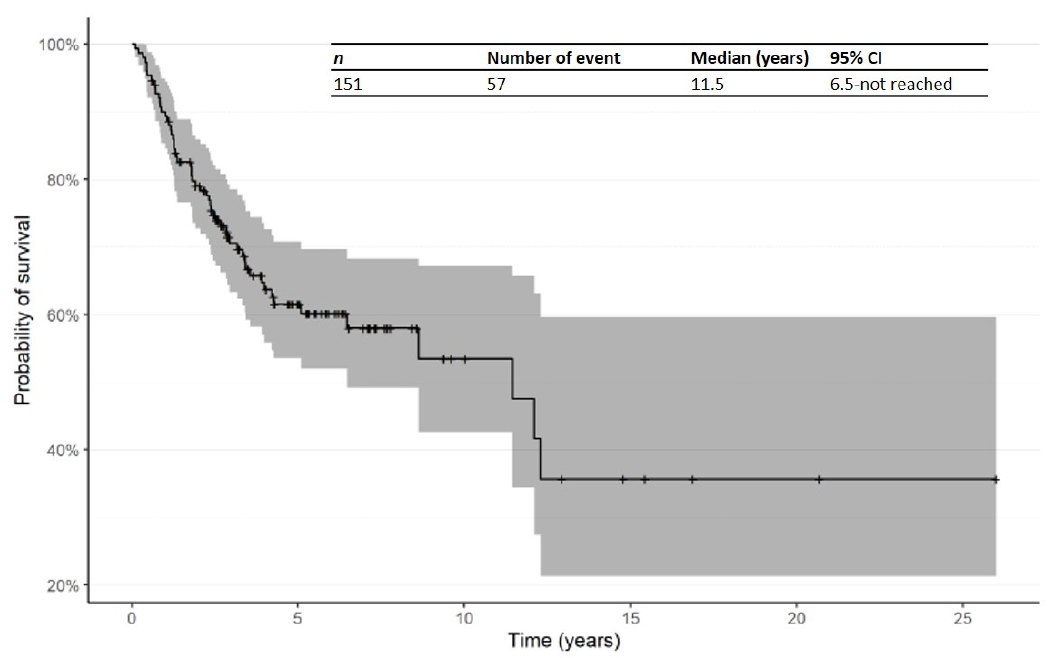
Figure 3. Kaplan–Meier curve for OS from time of first relapsed/refractory in patients receiving second-line therapy. Abbreviations: CI: confidence interval; OS: overall survival; R/R: relapsed/refrac- tory .